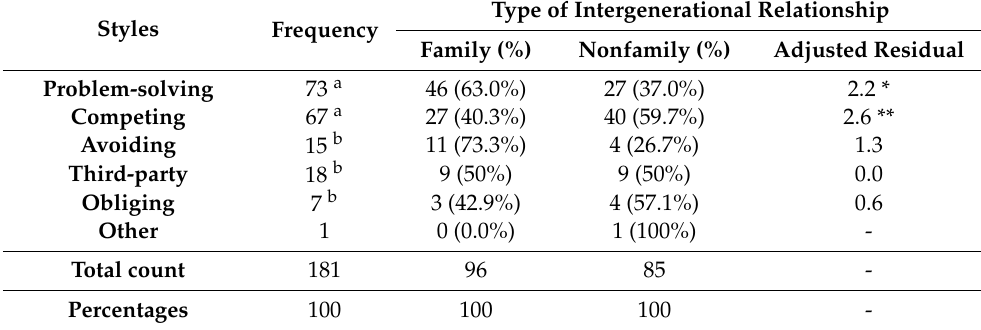
Table 4. Conflict management styles used by older adults in intergenerational conflicts in family and nonfamily contexts.